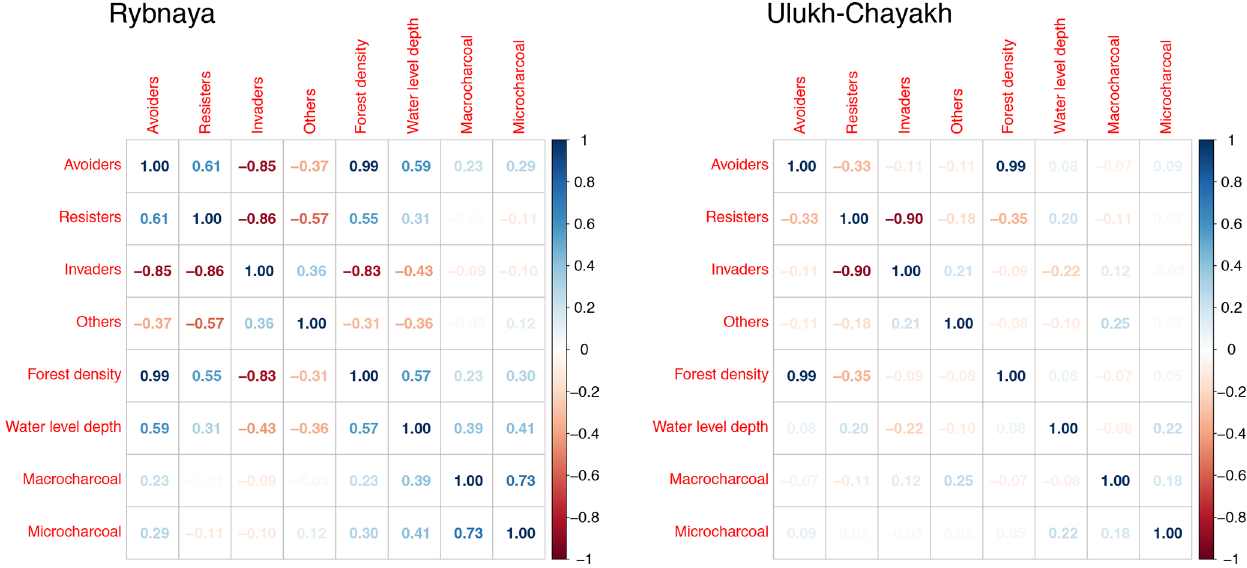
Figure A1. Correlation coefficients for the Rybnaya and Ulukh–Chayakh sequences. Note that forest density refers to the dark-to-light taiga